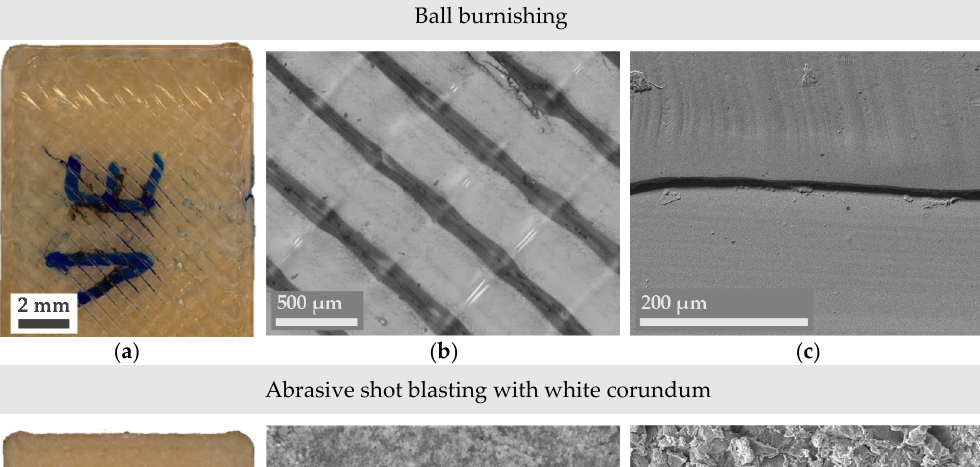
11 of 14 Figure 4. Digital microscope ( a , b , d , e ) and SEM micrographs ( c , f ) of the thermally treated Ultem 392 parts. 393